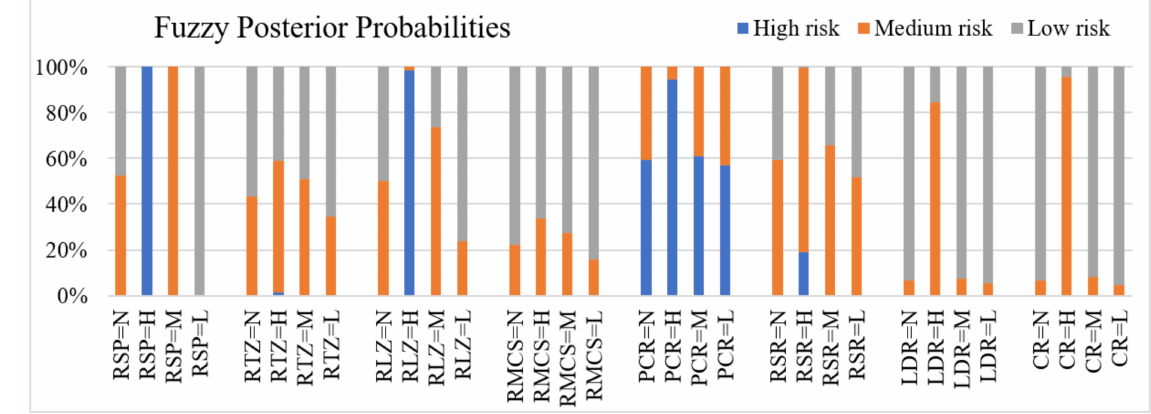
Figure 7. The fuzzy posterior probability diagram of the node “Risk in space launch”.